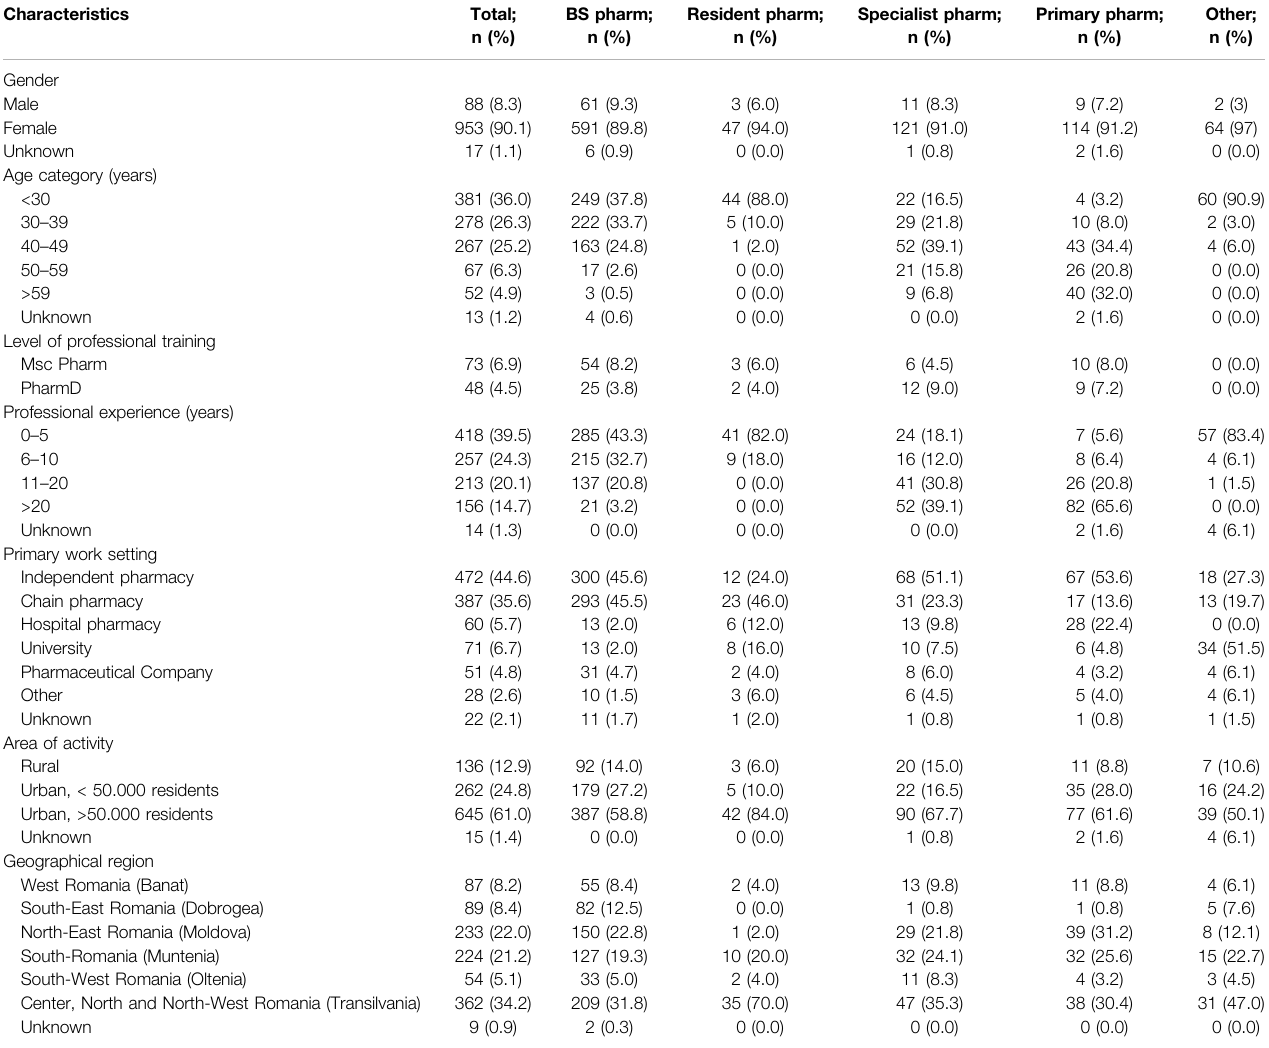
TABLE 1 | Demographics of survey